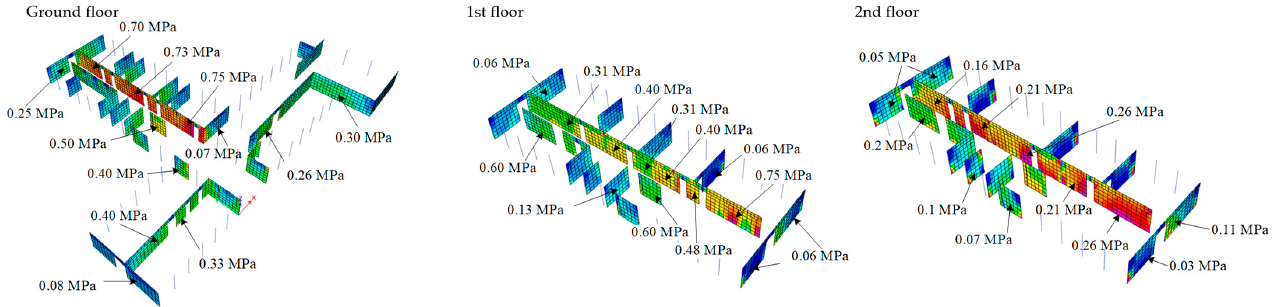
Figure 11. Normal stresses in masonry walls due to permanent loads.